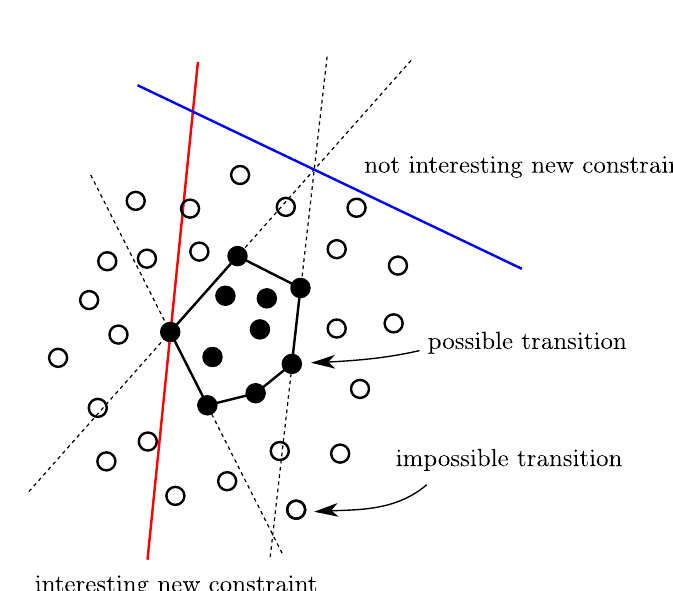
Figure 1: Example of the convex hull of a set of possible transitions. Since in practice transitions only lie on the hypercube { 0 , 1 } m , this figure is just a sketch to give intuition about our